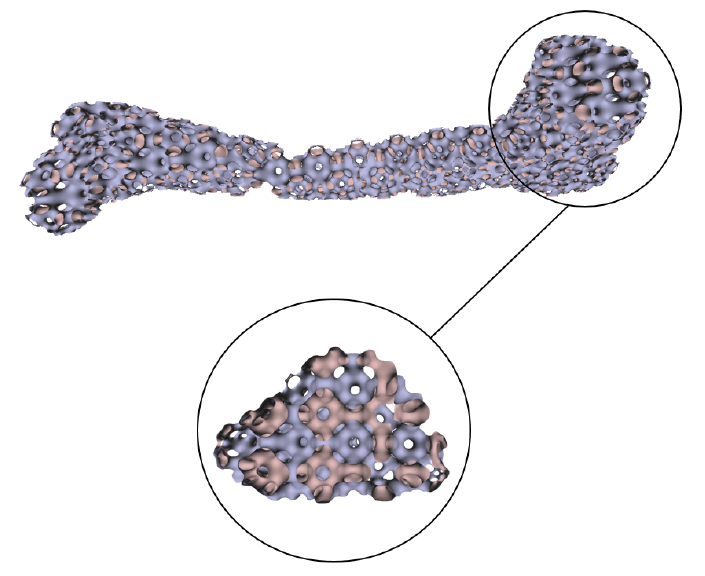
Figure 15. Porous TIS surface constrained by the femur’s